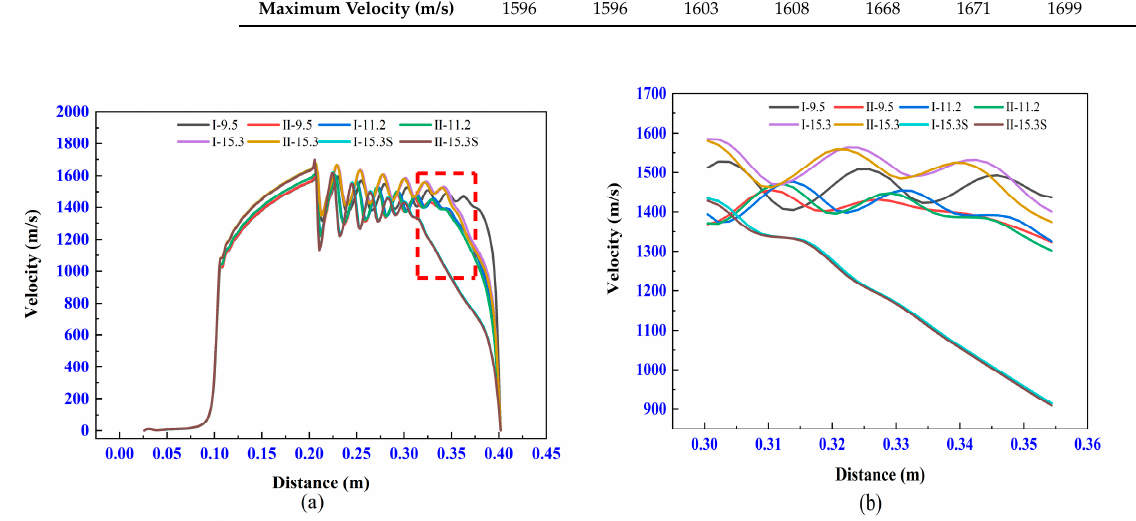
Figure 10. Velocity at the axis of the model ( a ) and a partially enlarged view of the red areas ( b ). Table 3. Maximum velocity corresponding to different experimental schemes.